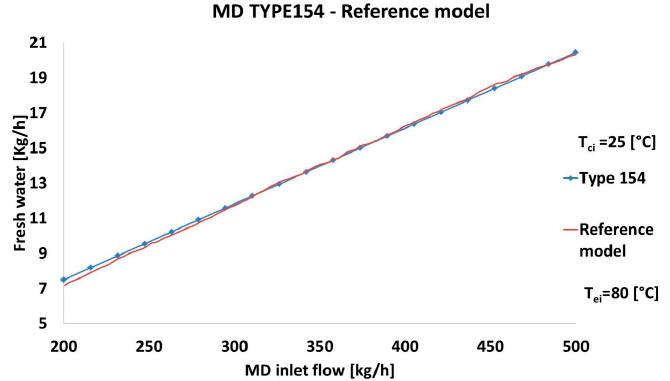
Figure 5. TRNSYS ® type and reference model for the PGMD unit (TYPE154 validation).